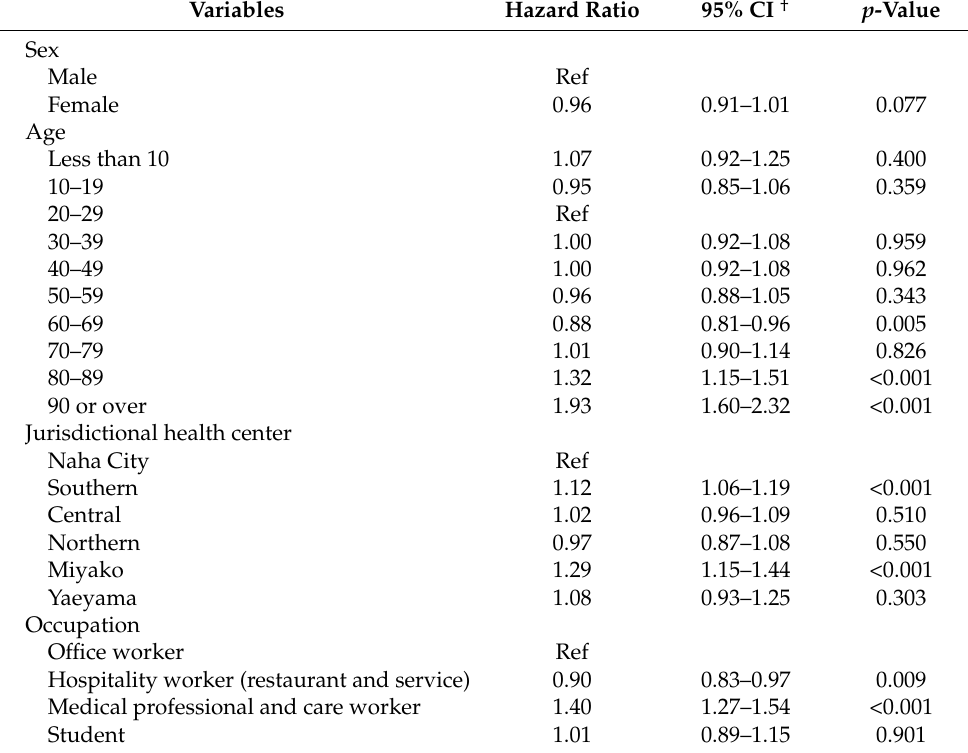
Figure 1. Survival Analyses ( A ) Age, ( B ) Jurisdictional health center, ( C ) Occupation, ( D ) Presumptive route of infection, ( E ) Month of onset, ( F ) Day of the week of onset. Table 3. Cox regression analysis of days from symptom onset to diagnosis (Model 1).